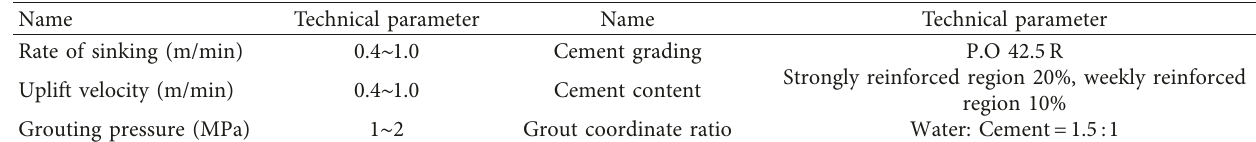
Table 3: Construction parameters for triple-shaft mixing